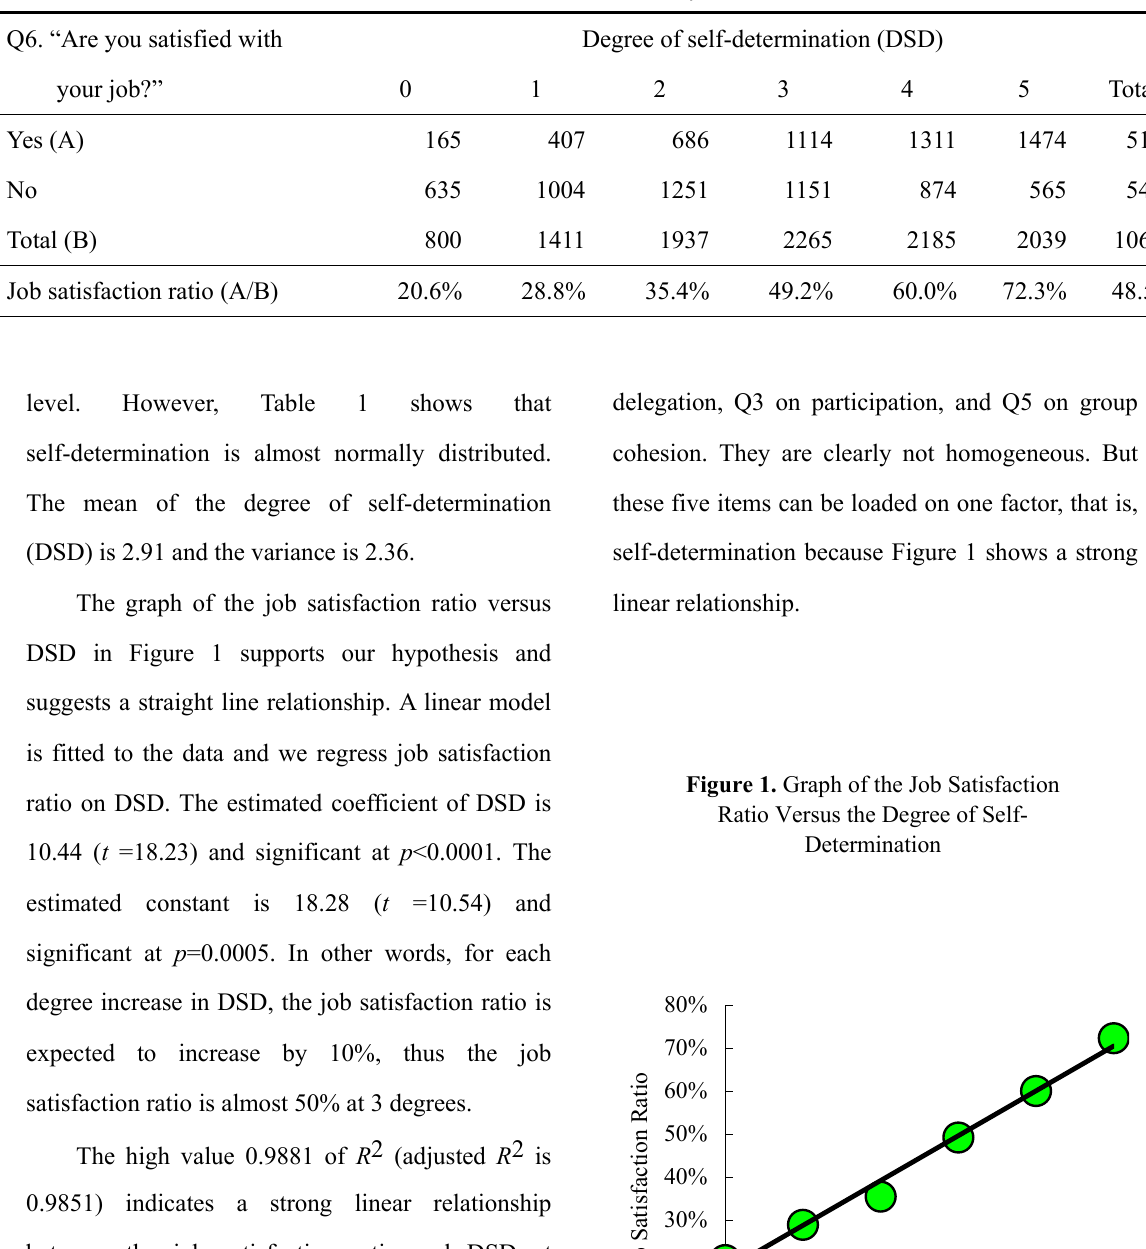
Table 1. Pooled Results of 11 Surveys in 1990 to